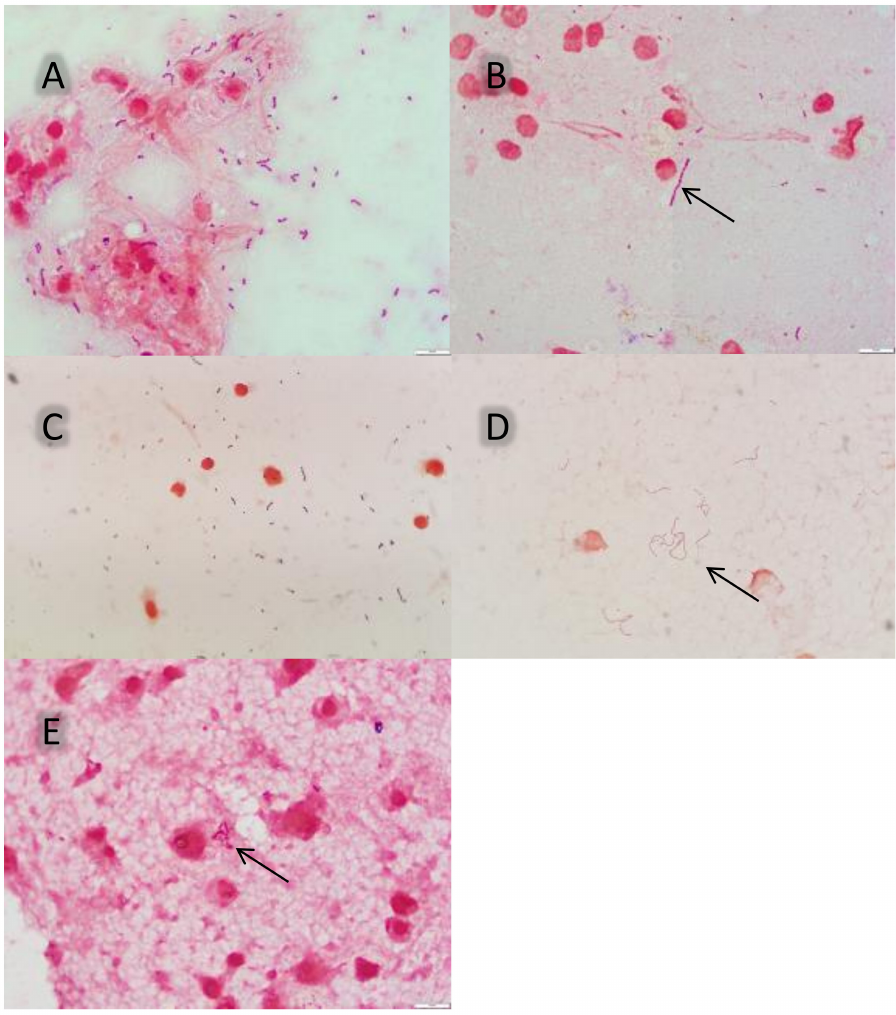
Figure 2. Gram staining of smears of the leptomeninges of pigs: ( A ) multiple Gram-positive coccoid shapes with short chains (5–10 coccoid shapes). Bacterial culture of the leptomeninges was positive for Streptococcus spp. (1000 × ); ( B ) a chain (arrow) with 18 coccoid shapes (1000 × ). Bacterial culture of the leptomeninges was positive for Streptococcus spp; ( C ) multiple short chains with Gram-positive coccoid shapes. Bacterial culture of the leptomeninges was positive for Streptococcus spp. (1000 × ); ( D ) multiple long chains (>10 coccoid shapes) (arrow). Bacterial culture of the leptomeninges was positive for Streptococcus spp. (1000 × ); ( E ) rod-shaped, Gram-negative bacteria (arrow). Bacterial culture of the leptomeninges was positive for G. parasuis (1000 ×